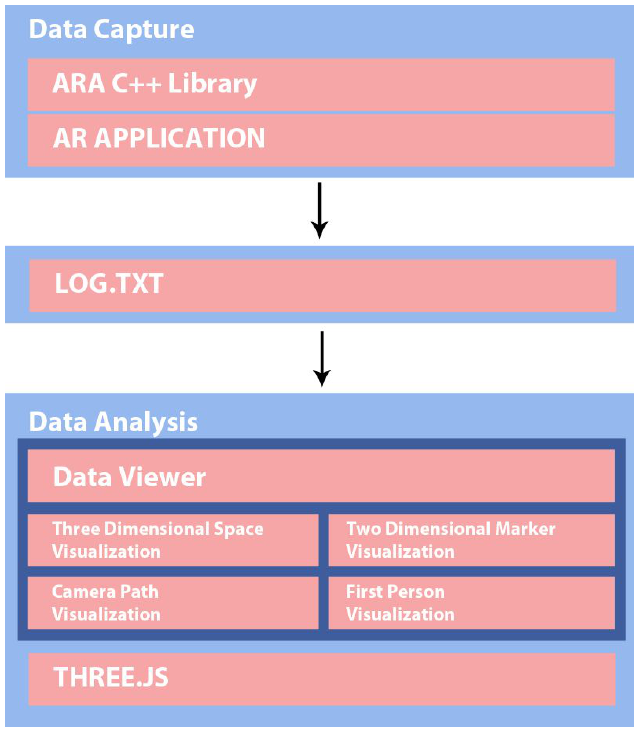
represent the camera center, while the following three numbers represent its view direction, the last integer number represents the time spent in this state in milliseconds. This file sizes 2MB to a 60s record and is used as input to the last step, the data viewer, a tool developed using THREE.JS library [22] which can run in modern web browsers.